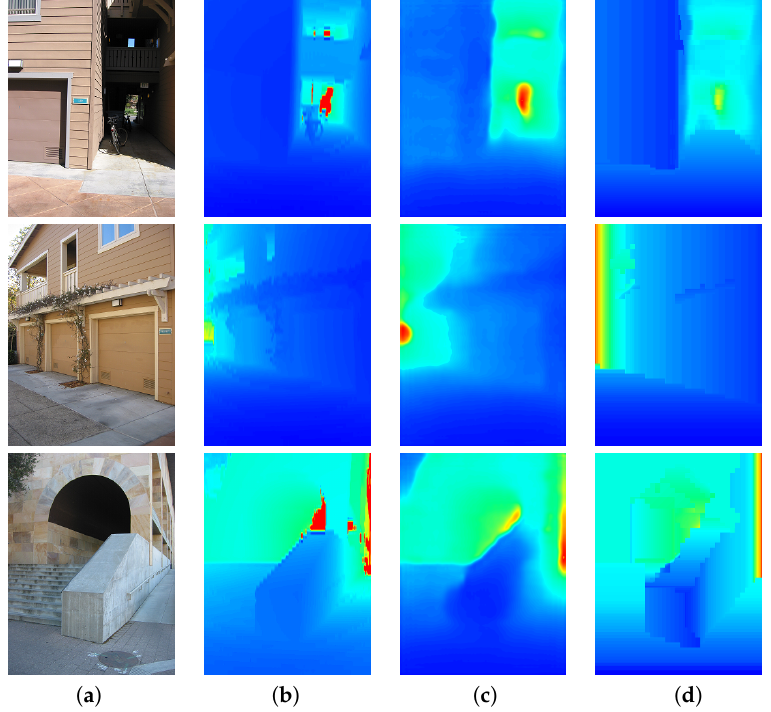
Figure 6. Examples of qualitative comparisons on the Make3D dataset. Colour indicates depths (red is far; blue is close). ( a ) Input image; ( b ) Ground-truth; ( c ) DCNF-FCSP [26]; ( d ) Our refined